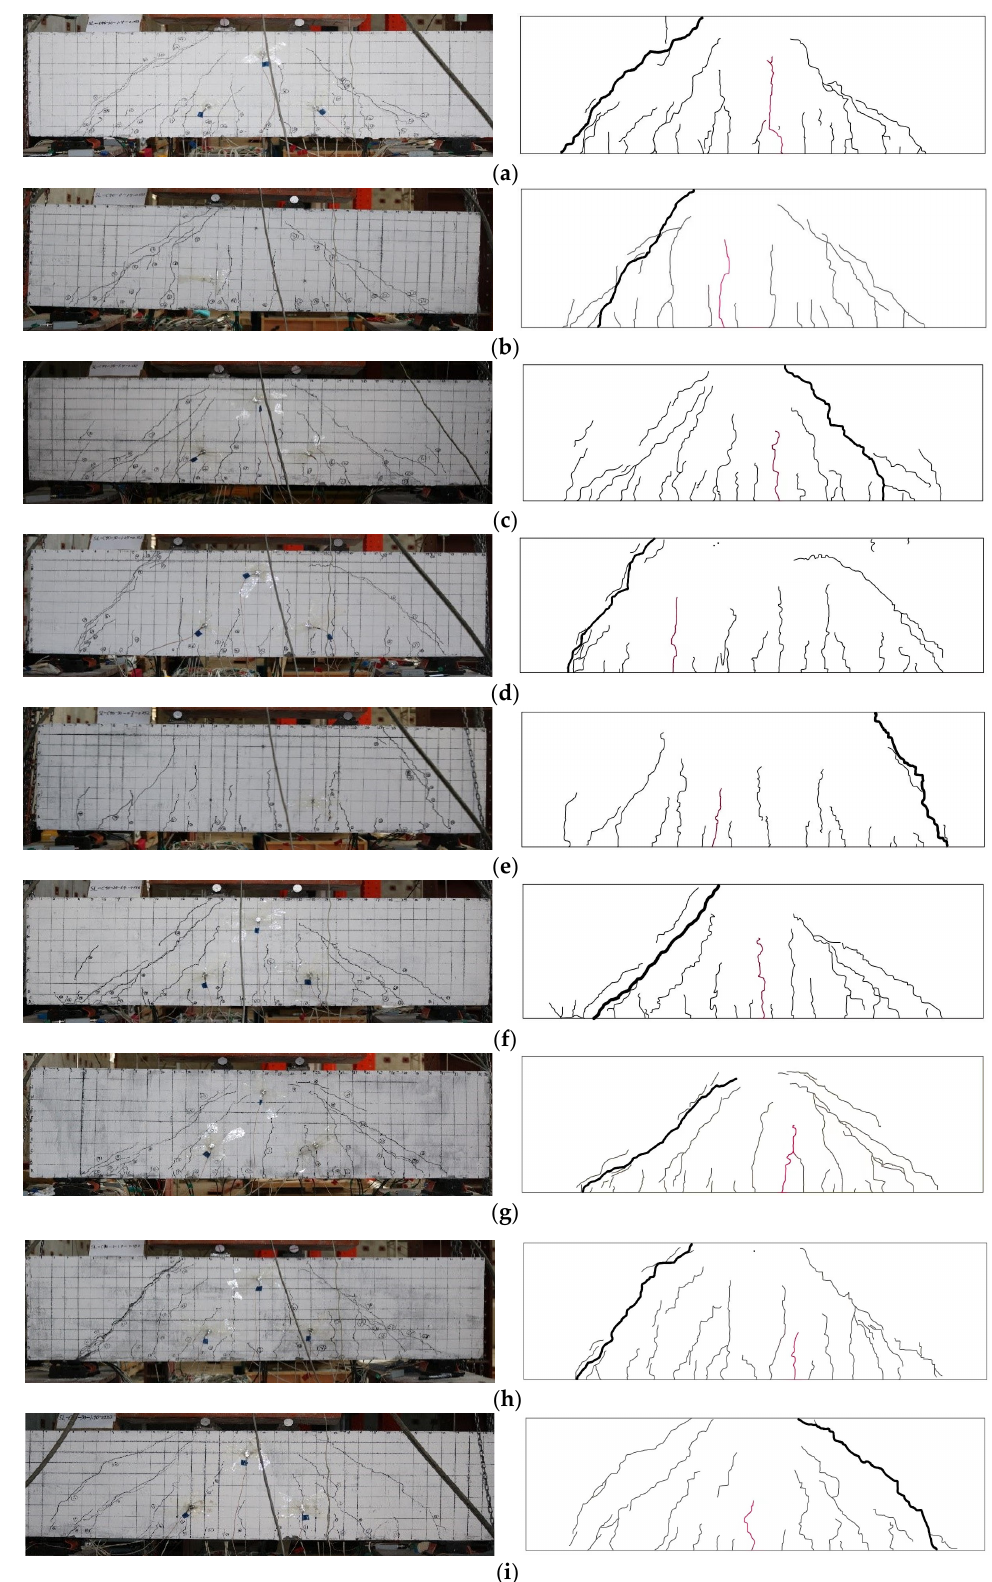
Figure 6. Crack pattern of the specimen. ( a ) CC1. ( b ) A1. ( c ) A2. ( d ) B1. ( e ) B2. ( f ) C1. ( g ) C2. ( h ) D1. ( i ) D2. Table 6. Summary of test results for specimens.